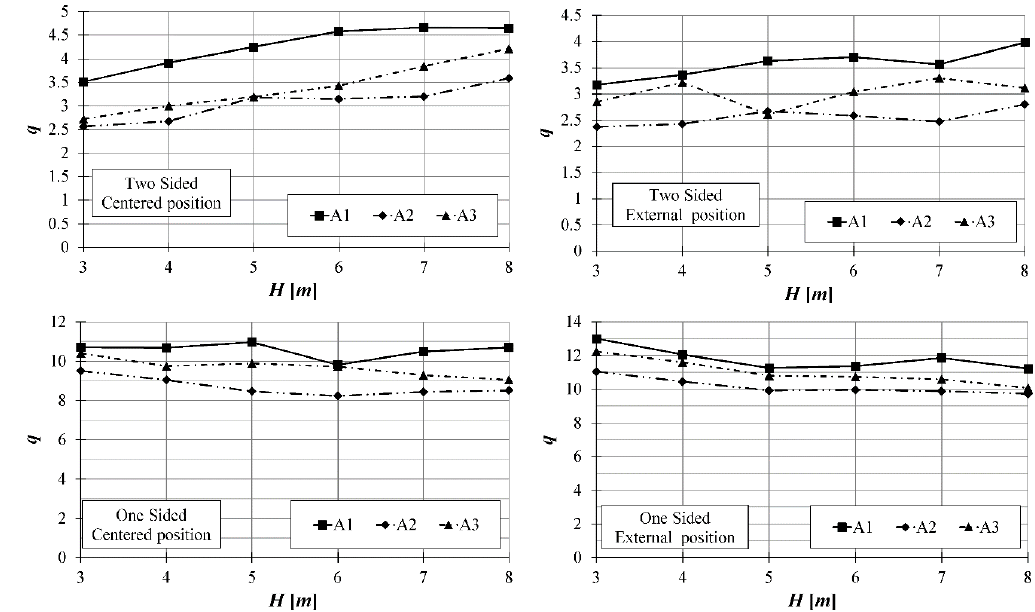
Figure 12. Force reduction factor versus height H — α =7.5°, ρ =1‰, GFRP material.